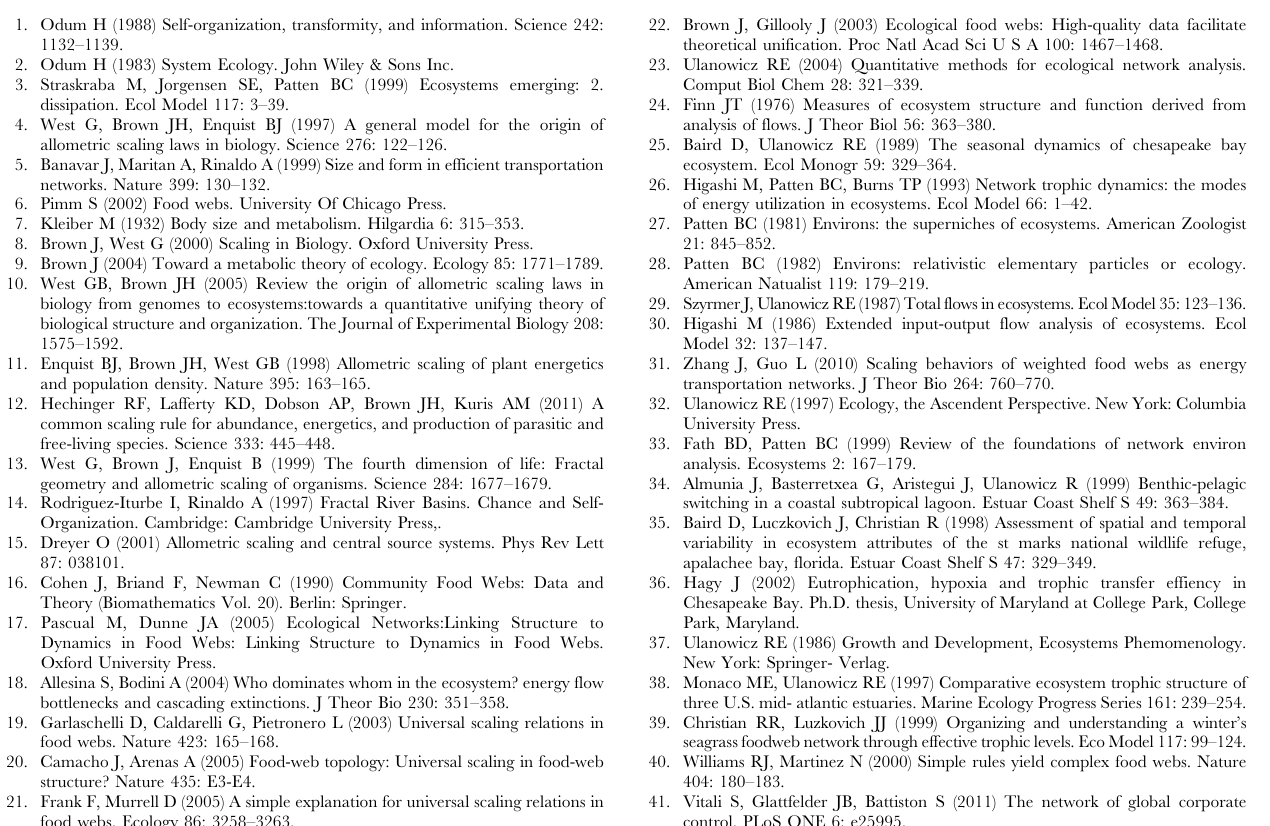
File S1 Contains. Figure S1. The relationships between c and g for different balancing methods. Naive, input, output, and average stand for different balancing methods. Figure S2. An example network showing the calculations of A i and C i . Figure S3. Allometric Scaling Patterns for Null Models based on the Mondego Network. Figure S4. Comparison of Allometric Scaling Exponents of Original Networks with the Null Models Figure S5. Dissipation Law for Null Models of Mondego Network. Figure S6. g and R 2 Change with h , b and c . Figure S7. g and R 2 Change with c for different random networks. Figure S8. g and R 2 Change with c and a on the Random Networks based on Spanning Trees. Figure S9. c and g Relation Adjusted by the Flow Adjusting Algorithm on the Collected Ecological Networks. Figure S10. Dissipation Scaling Law for the Original and Balanced Flow Networks of Baydry and Rhode. Table S1. Unbalanced Flux for Each Ecological Network. Table S2. Comparison among Different Balancing Methods for Allometric Scaling Exponent.